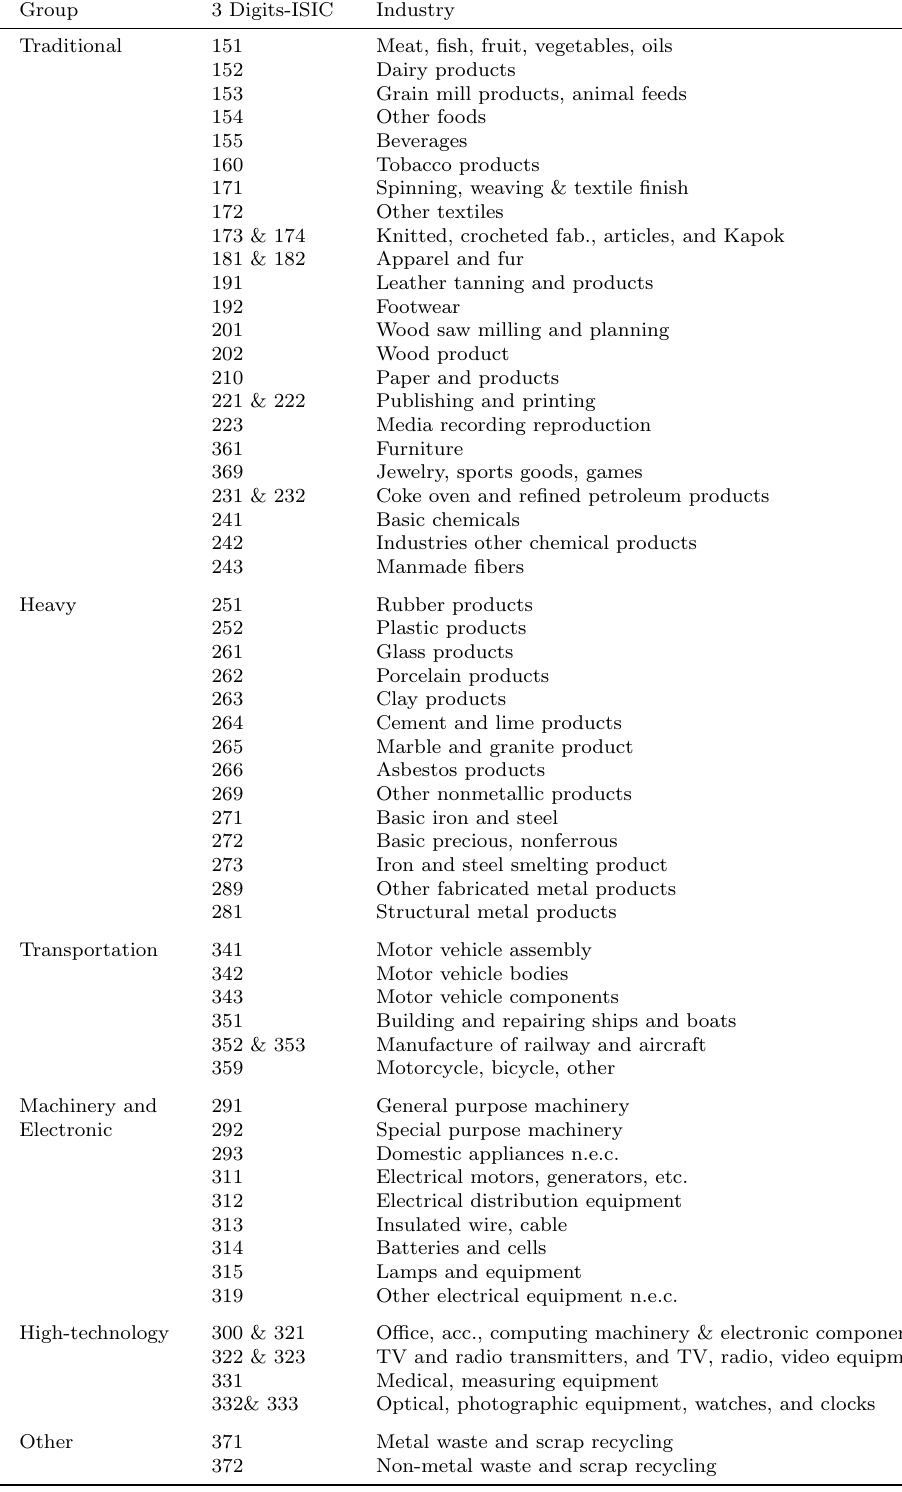
Table A.3: Group and